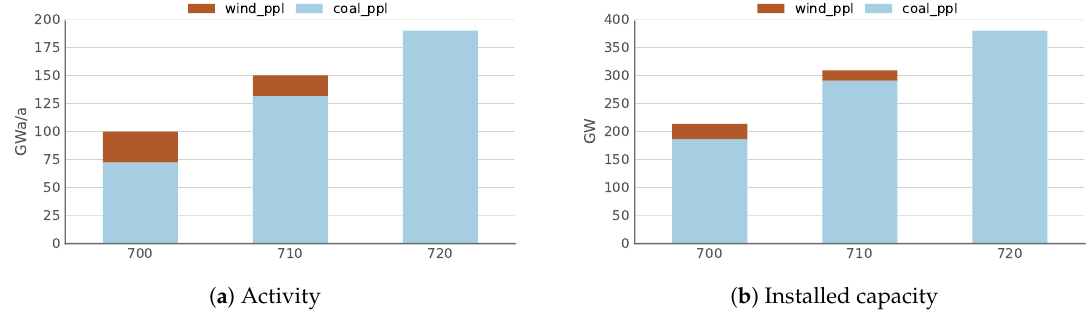
Figure 5. Power plant activity and capacity in the ‘baseline’ scenario (Listing